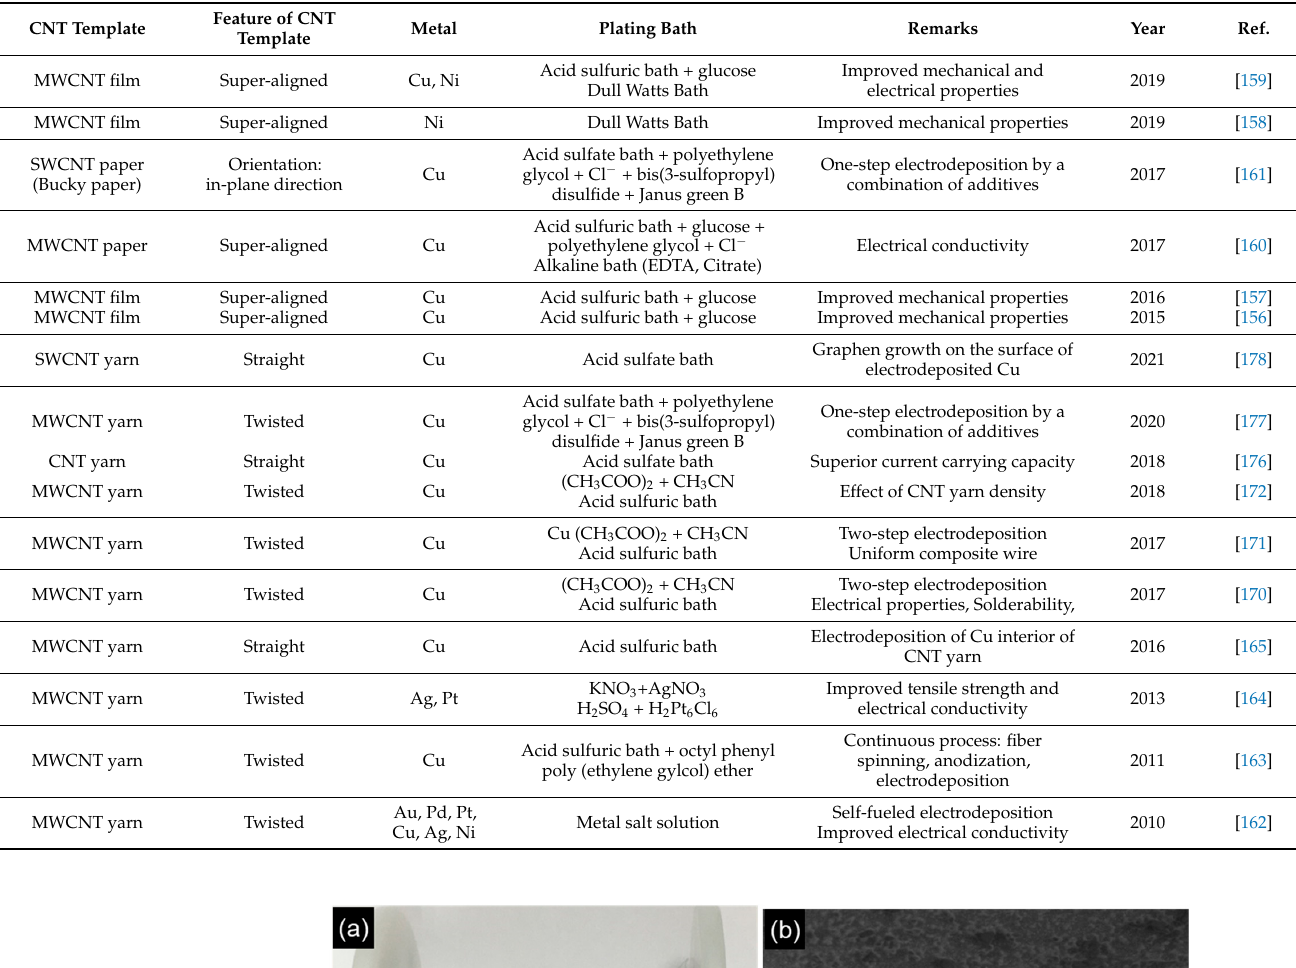
Table 4. Fabrication conditions of Metal/CNT Composites by Electrodeposition using CNT Template. sectional SEM image of the CNT/Cu composite sheet by electrodeposition using a plating bath with additives, ( d ) C distribution of ( c ), and ( e ) Cu distribution of ( c ). (Figure 15 is adapted from [161]).